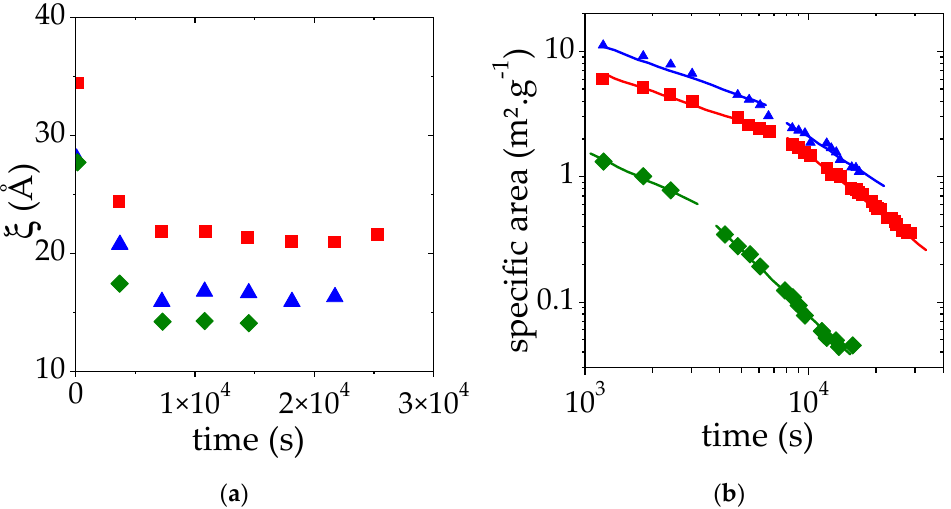
Figure 7. Apparent correlation length obtained ξ ( a ) and specific area ( b ) as a function of time for a solution at a volume fraction of 0.017 ( ♦ ), 0.065 ( ■ ), 0.104 ( ▲ ). This variation was monitored during the LCST phase separation induced by a temperature jump from 25 °C to T CP + 10 °C. ξ and specific area were deduced from the fit of SANS data by Equation (3). The solid lines correspond to the fit of the time evolution of the specific area to power laws.